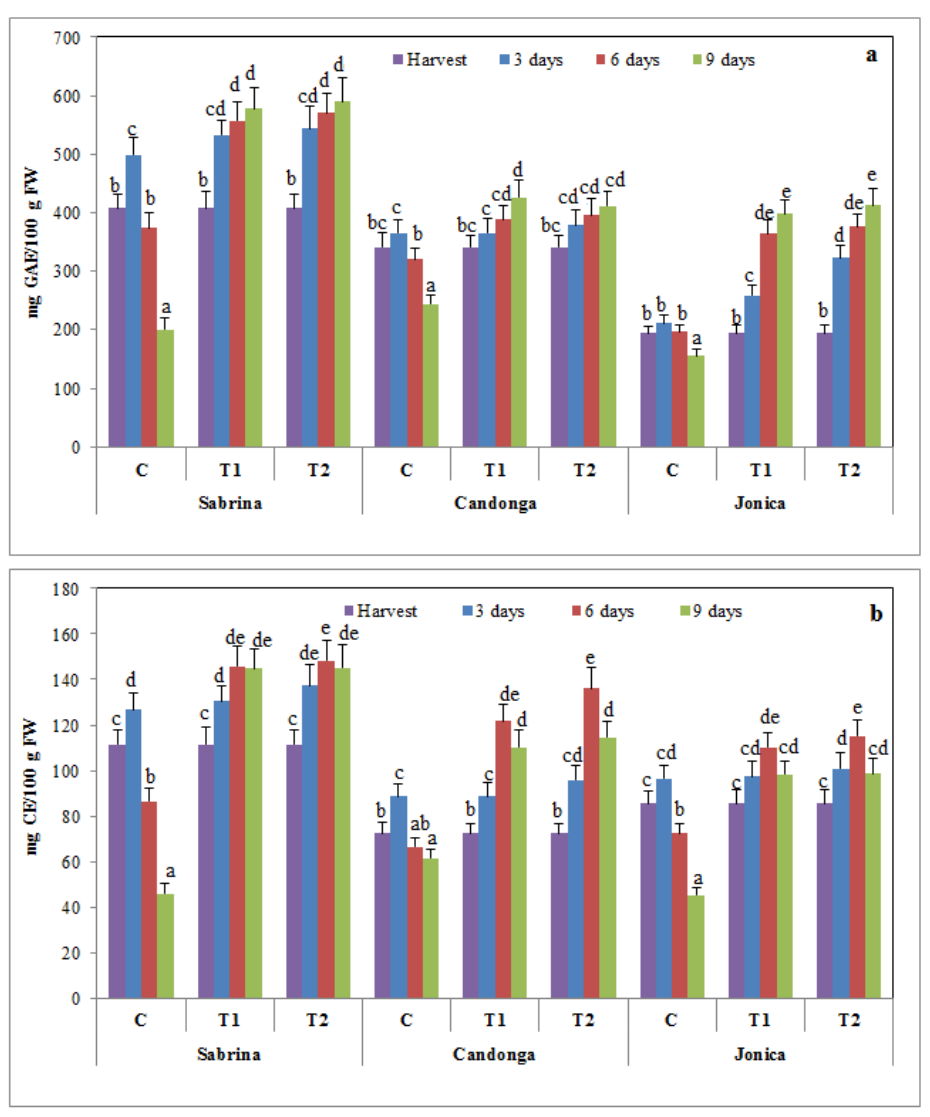
Figure 2. Changes in polyphenols ( a ) and flavonoids ( b ) content of strawberry cultivars during cold storage at 2 °C for nine days (error bars indicate standard